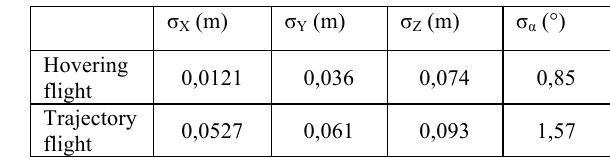
Table 4. Pose and rotation measurement error of the MLZ algorithm